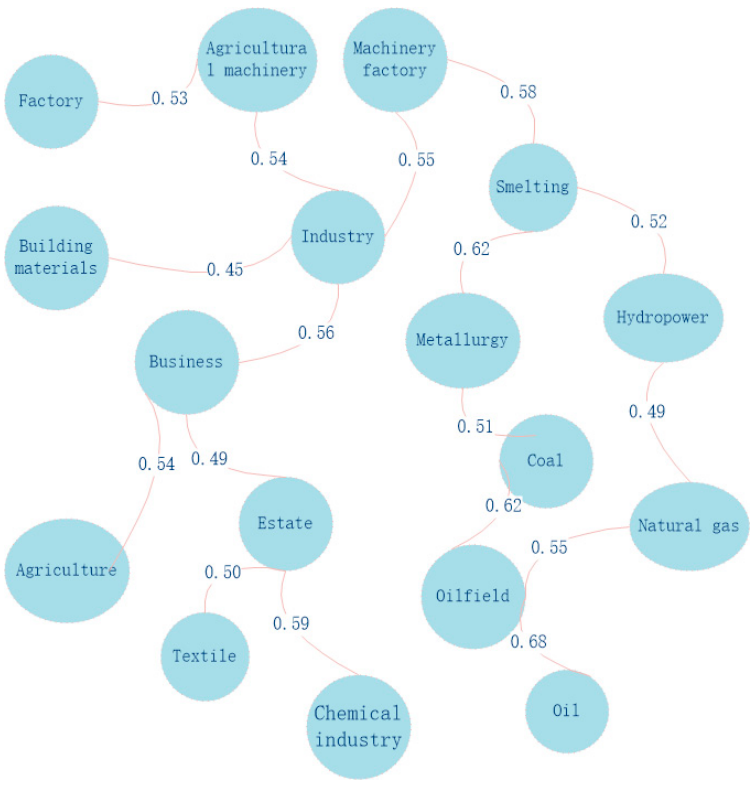
Figure 2. Feature pair adjacency graph.